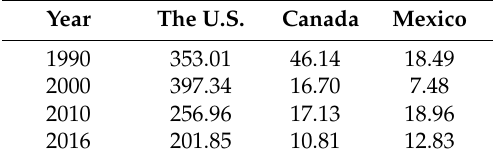
Table 6. Value of UK textile materials import from North America (unit: dollars in millions). Year The U.S.